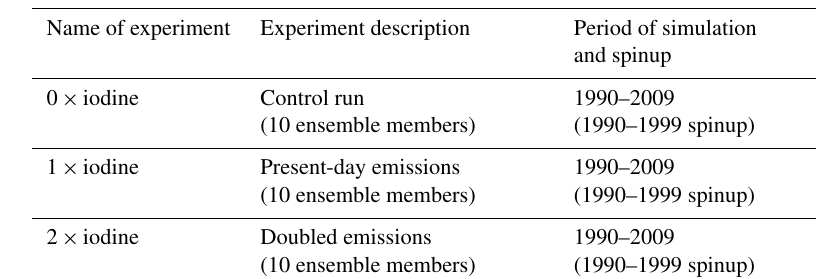
Table 4. The experiments with SOCOL-AERv2-I.